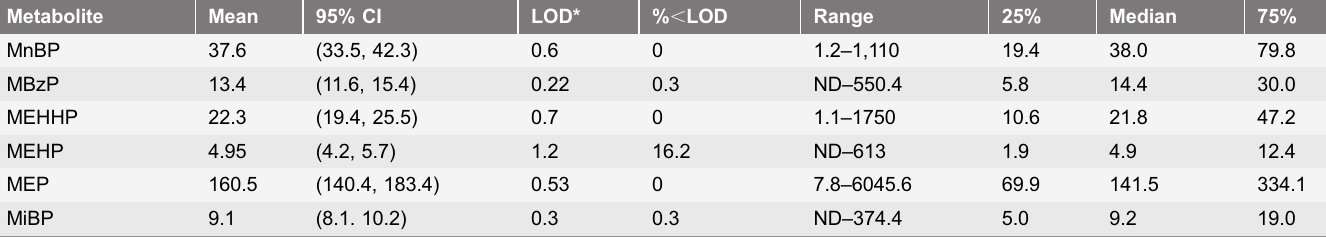
Table 2. Distribution of Phthalate metabolites (ng/ml) in maternal spot urine during the third trimester of pregnancy (n 5 328).